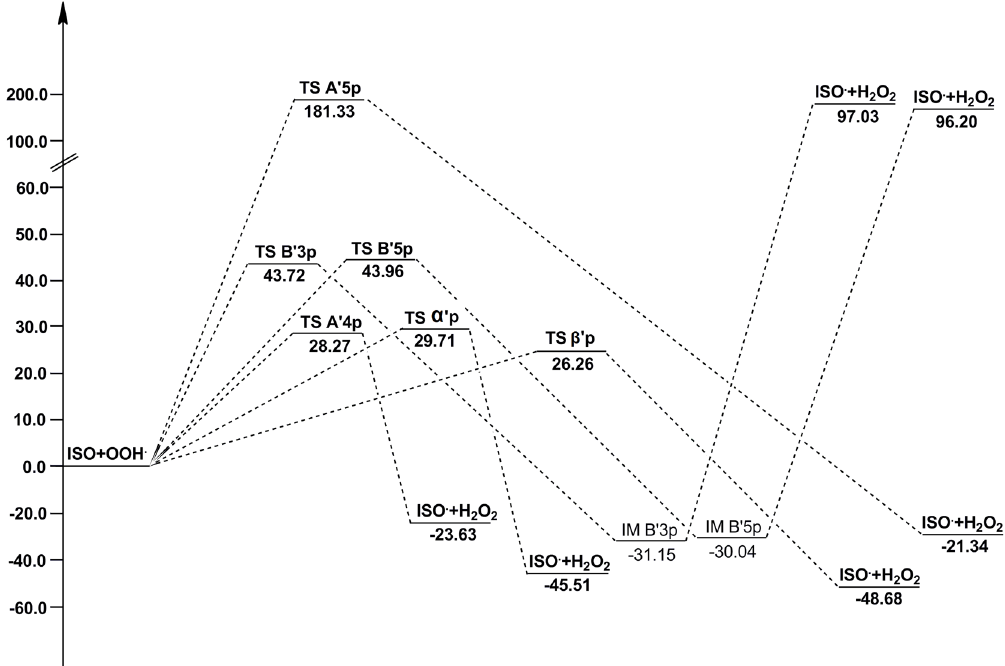
Fig 10. The potential energy surfaces of the reactions of ISO with (cid:129) OOH in the gas phase. The relative energies (in kJ/mol) were calculated at the M05- 2X/6-311++G(d,p) + ZPE level. To facilitate comparisons, the energy of the reactants are set to